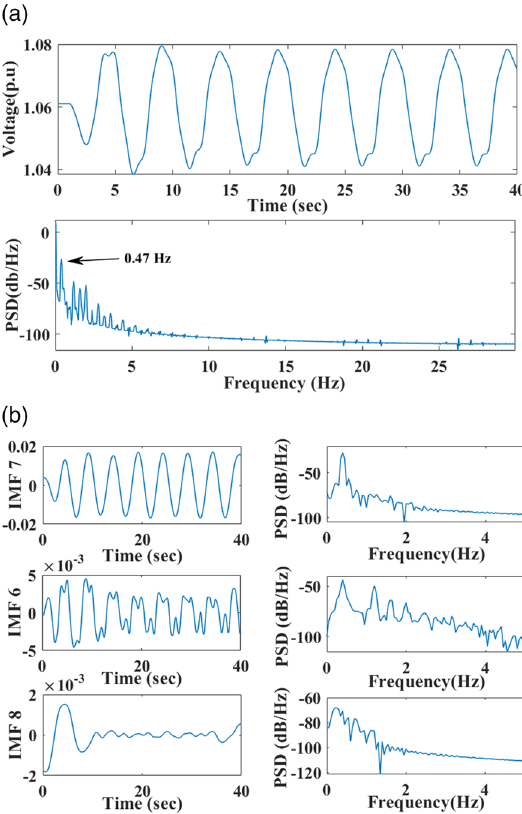
Fig. 7 a Simulated raw PMU signal and its PSD at bus 34. b Decomposed modes of the raw PMU data